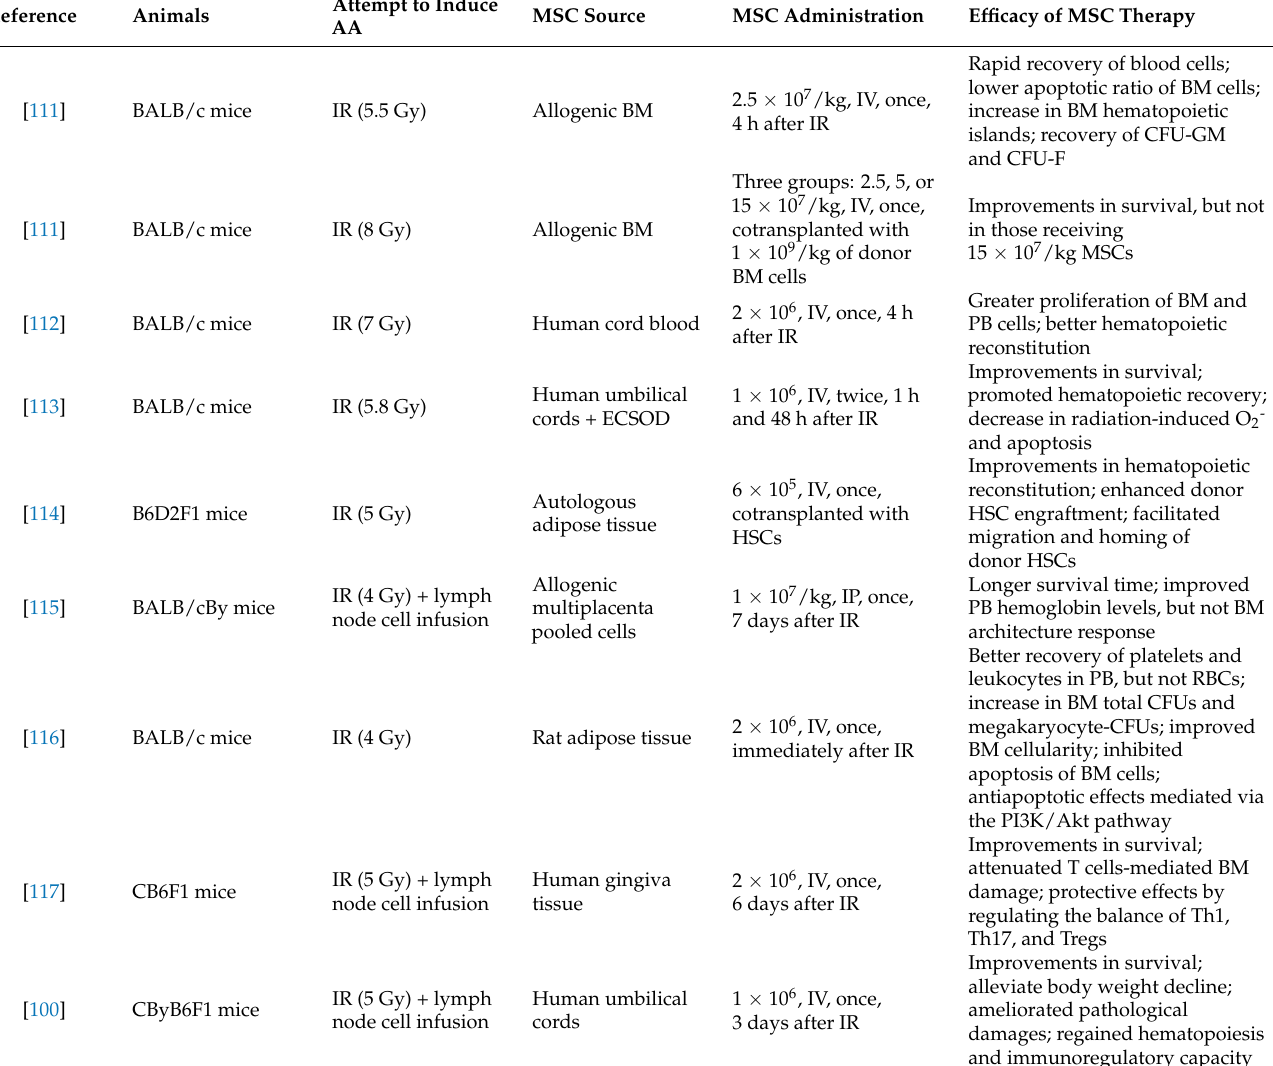
Table 1. MSC transplantation in animal models of